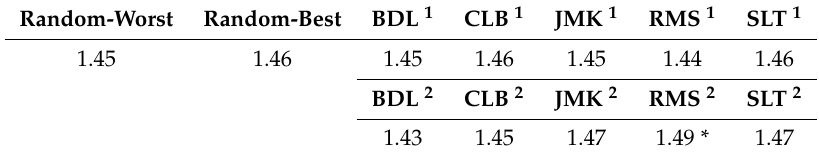
Table 3. Mean PESQ Results for BDL voice. Higher values represent better results. * is the best result. The superscript 1 means that the LSTM post-filter was pre-trained as ANN using natural parameters, while the superscript 2 means the same procedure applied with synthetic